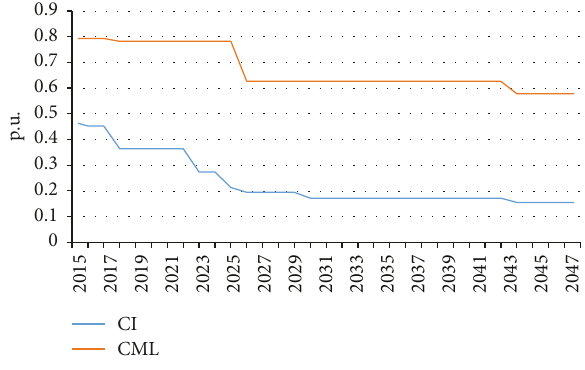
Figure 18: CML and CI; DECC4, 2015 –